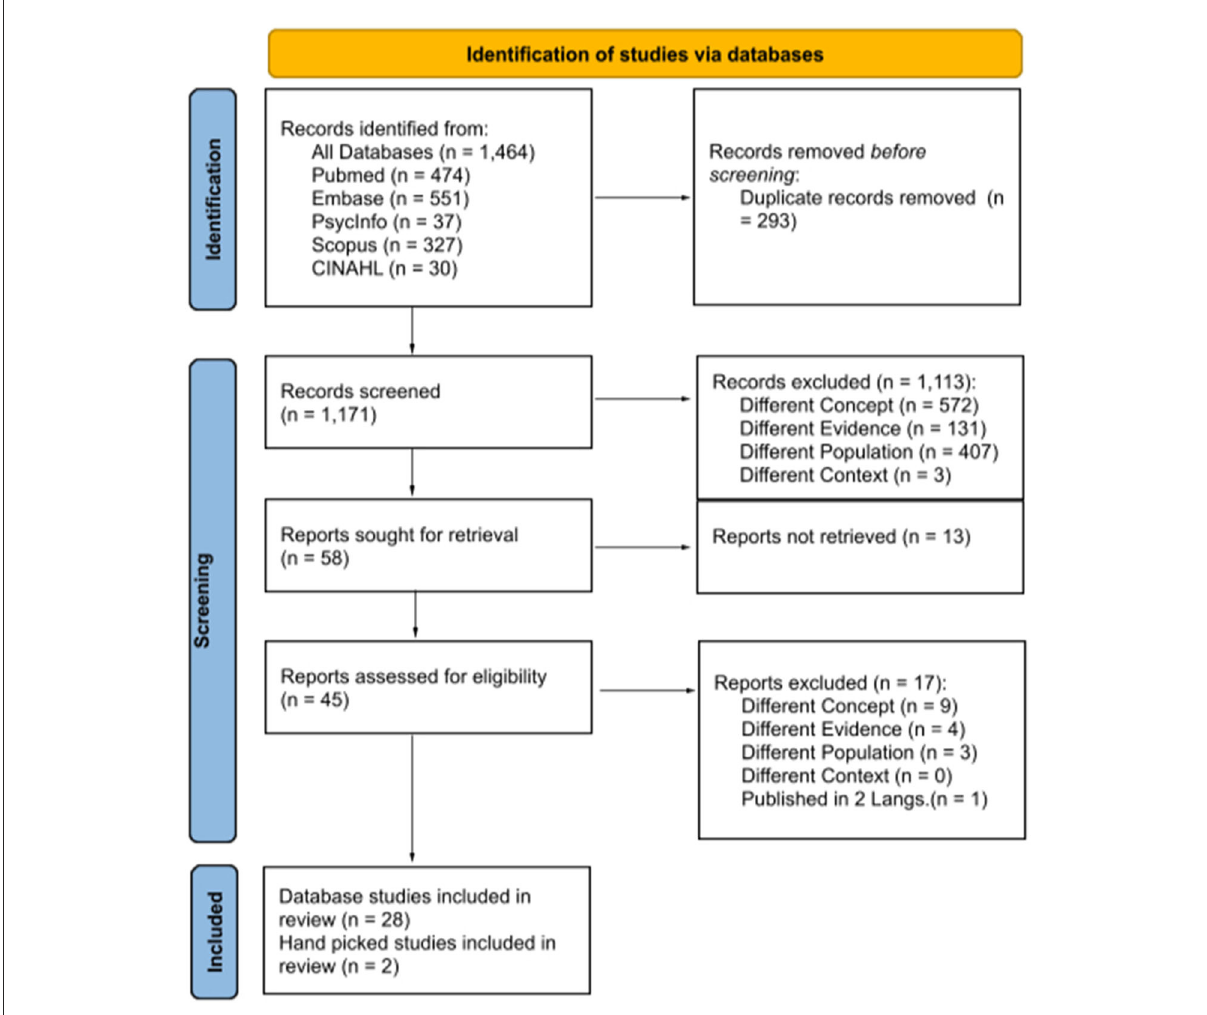
FIGURE1 PRISMA 2020 flow diagram of included studies identified via database search and hand pick. From Page et al. (30) https://prisma-statement.org/